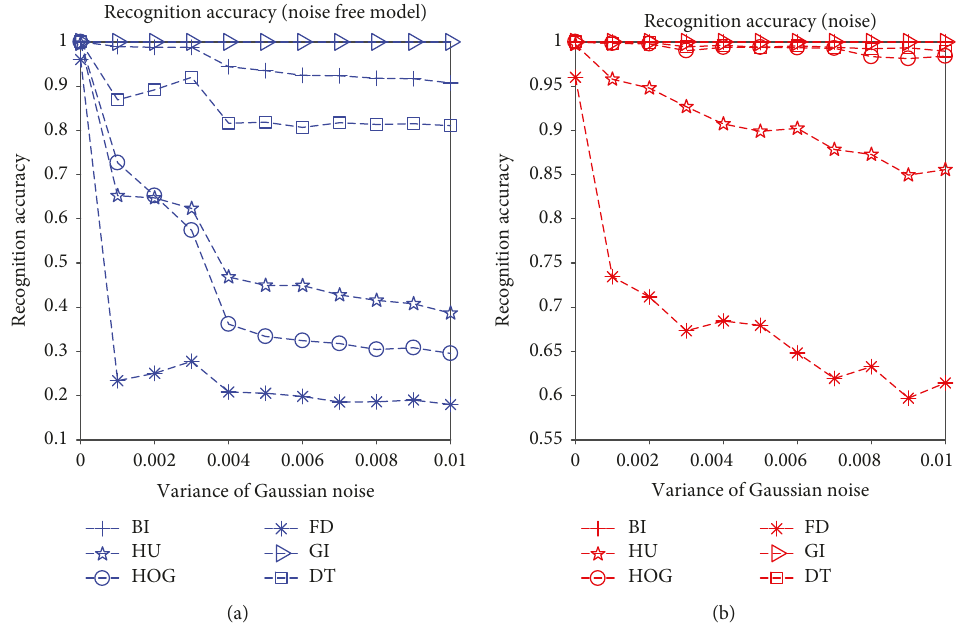
Figure 4: Noise robustness results of GPR for satellite recognition.